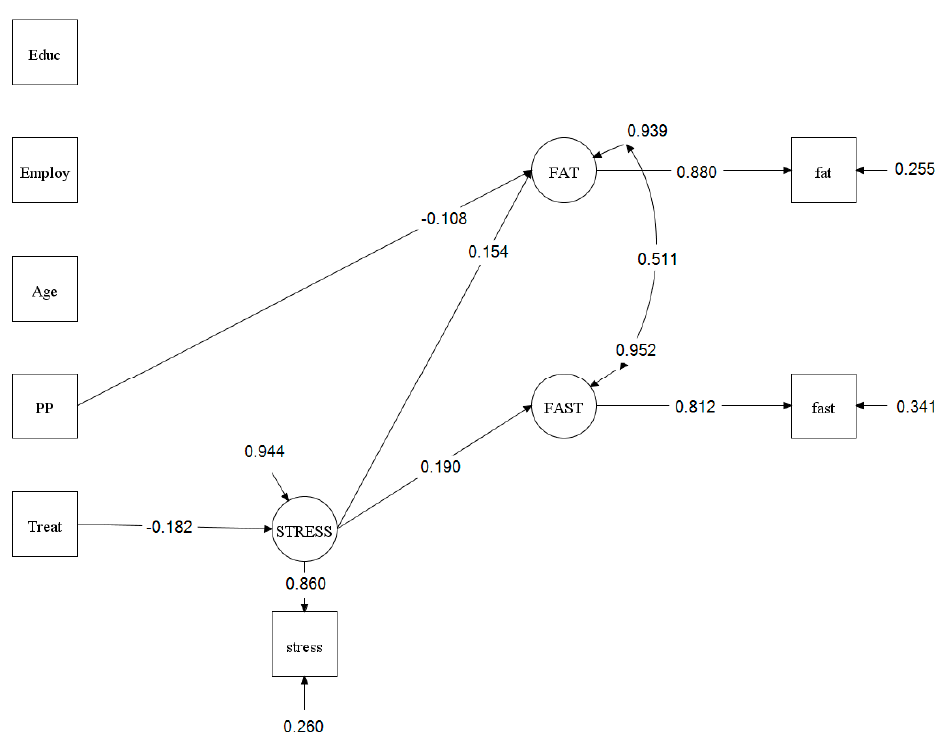
Figure 2. Significant Paths of Mediation Model Testing. Values presented in significant paths were standardized parameter estimate. Squares are used to indicate manifest or single item variables, whereas circles are used to represent unmeasurable latent variables. Treat (intervention) was an exogenous variable (a predictor or an independent variable). FAT (high fat intake) and FAST (fast food intake) were endogenous variables (outcome or dependent variables). STRESS (perceived stress) was a mediator (an endogenous variable). Educ (education), Employ (employment status), age, and PP (postpartum period) were covariates.